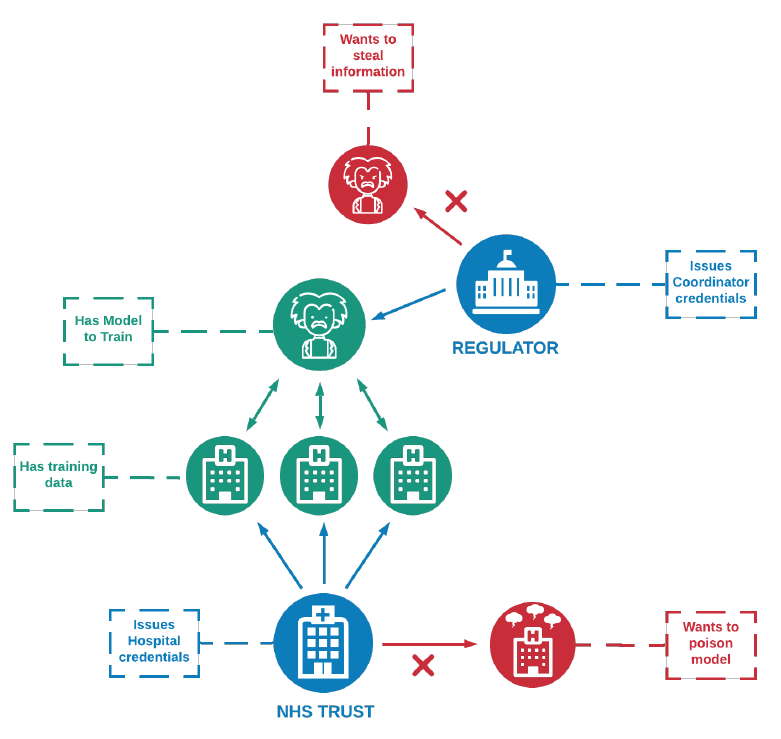
Figure 2. ML Healthcare Trust Model